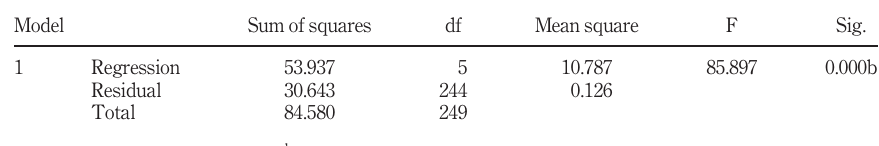
Model Sum of squares df Mean square F Sig. Regression 53.937 5